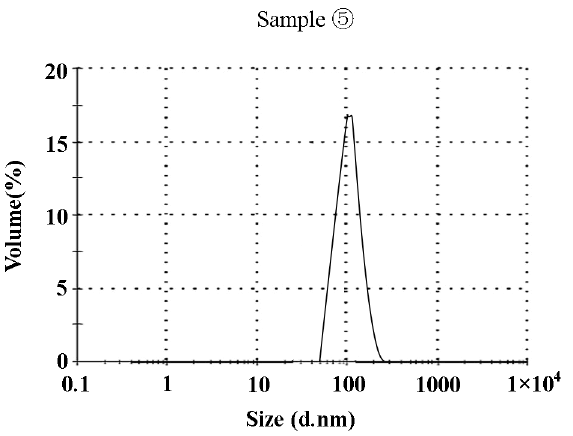
Figure 6. The particle size distribution of the system when the molar ratio of epoxy groups is E51:ED = 1:1.